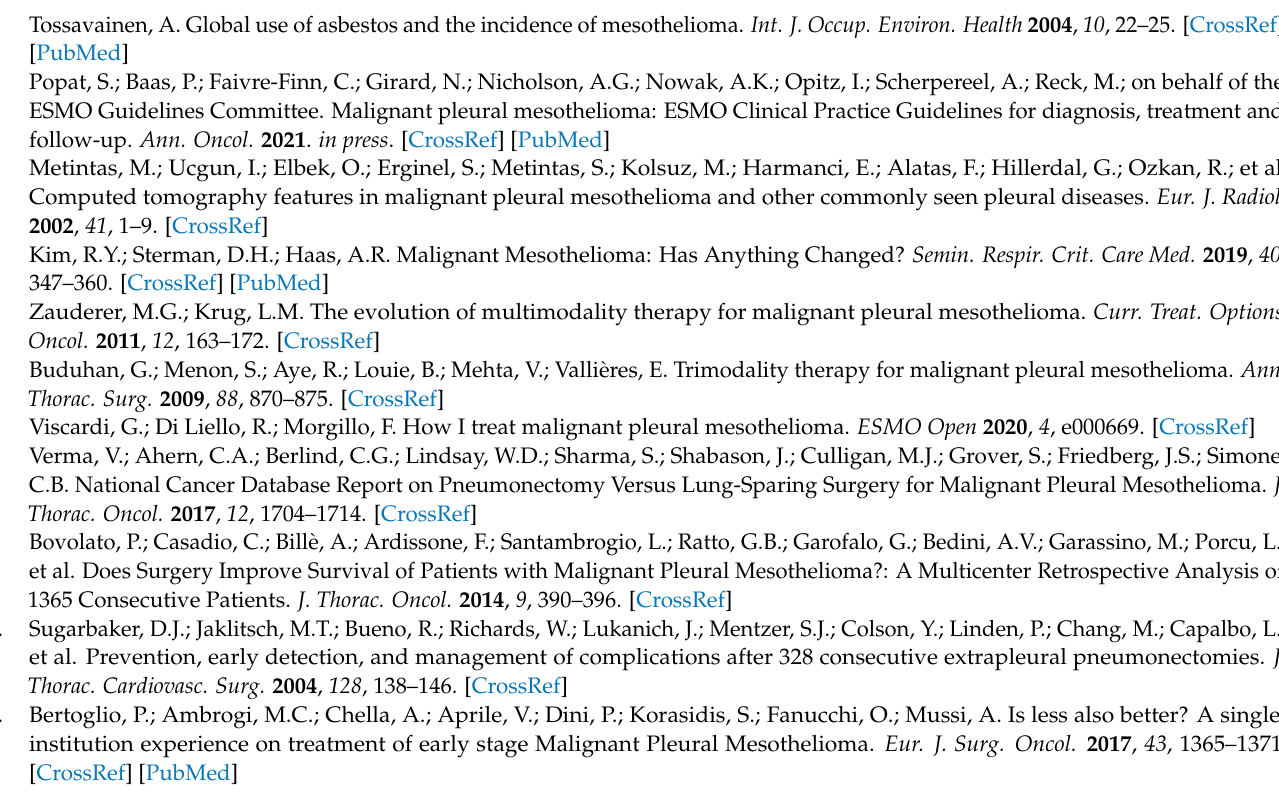
Figure S2: PFS ( A ) and OS ( B ) Kaplan-Meier curves by stage (1A vs.